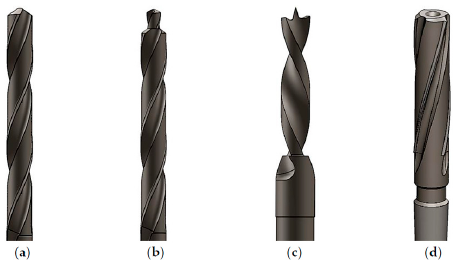
Figure 1. Selected drill geometries: ( a ) twist; ( b ) step; ( c ) Brad and Spur and ( d ) core drill.